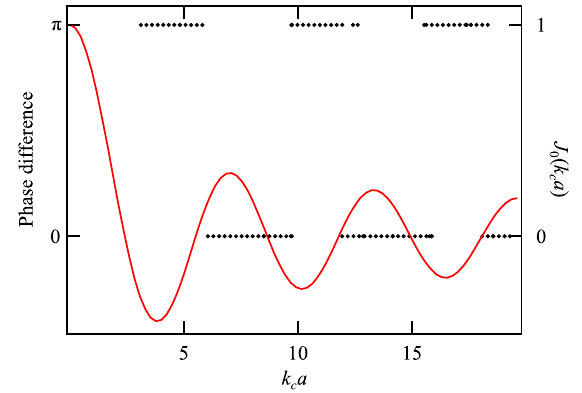
FIG. 2. The condensates flip from antisymmetric ( π phase difference) to symmetric states (zero phase difference), shown with black dots as a function of the product of the outflow wave vector k and the separation distance a . Here, we change a , c whereas k remains virtually unchanged. The solid red curve is the c Bessel function calculated versus the dimensionless parameter k